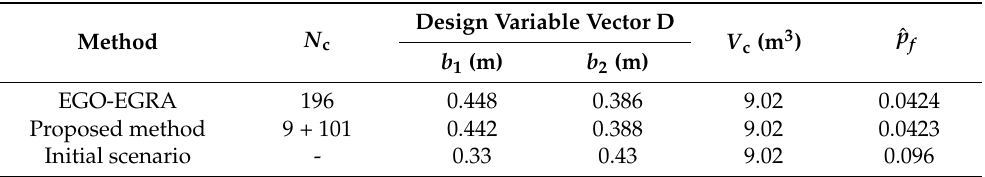
Table 7. Optimization results of Example 2.